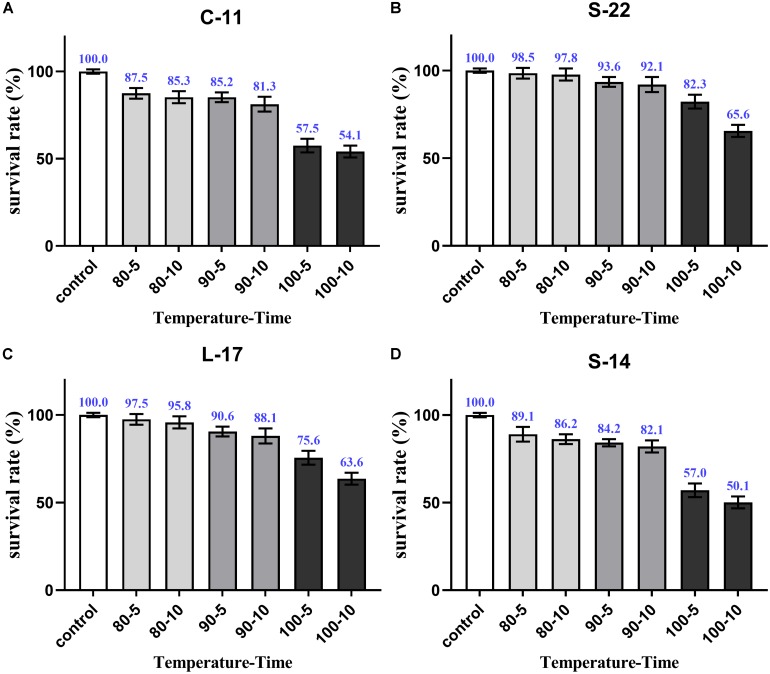
Heat resistance of the B. velezensis S-22 (A), L-17 (B), S-14 (C), C-11 (D). The survival rates of spores heated at 80, 90, and 100°C for 5 and 10 min separately are presented as means ± SD. The results are representative of three independent experiments.